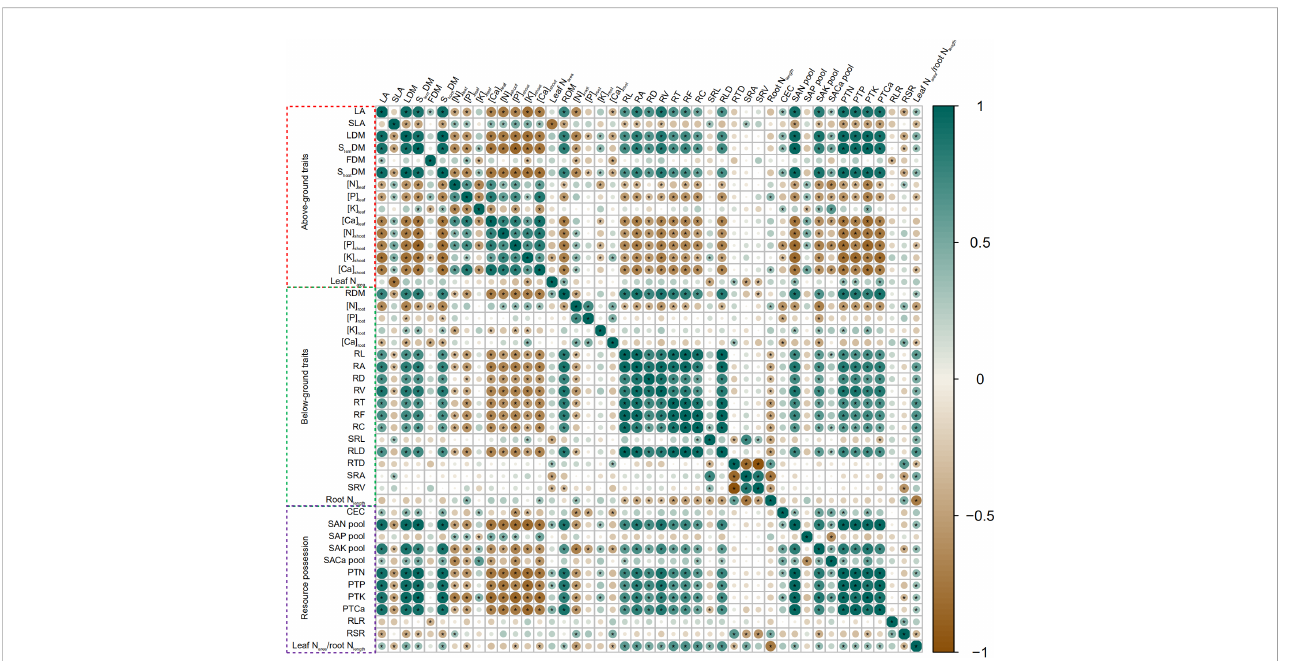
FIGURE 4 Heatmap of Pearson correlation coef fi cient between different traits of soil – plant systems across biochar and irrigation treatments. According to the legend, the scale of the circles and the darkness of each box color correspond to R 2 values; * indicates signi fi cant levels at p < 0.05. Increase and decrease in abundance are indicated in the colored bar with green and brown, respectively.